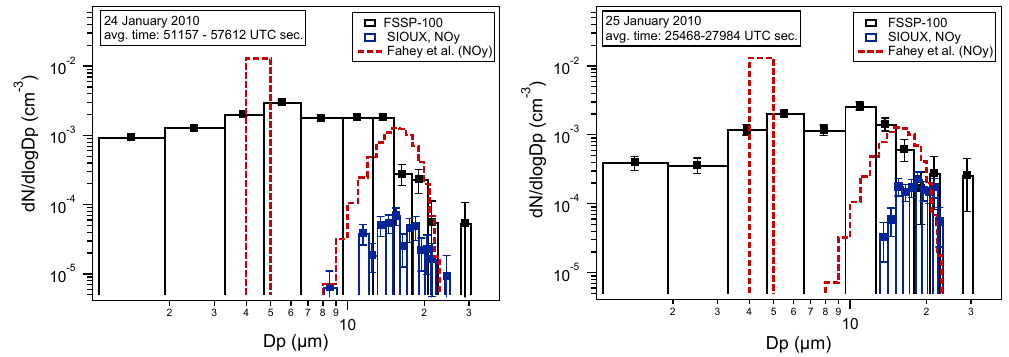
Figure 13. PSC particle size distributions of the FSSP-100 data for time intervals where the total NO y data of the SIOUX instruments allowed for extraction of particle data from single peaks, and for which diameters assuming NAT composition were derived. The sensitivity of the NO y instrument scales with particle volume, and thus only sizes above about 10µm could be retrieved. A particle-size-independent enhancement factor was used, which might explain some of the discrepancy in the particle numbers between the NO y and the optical measurements.